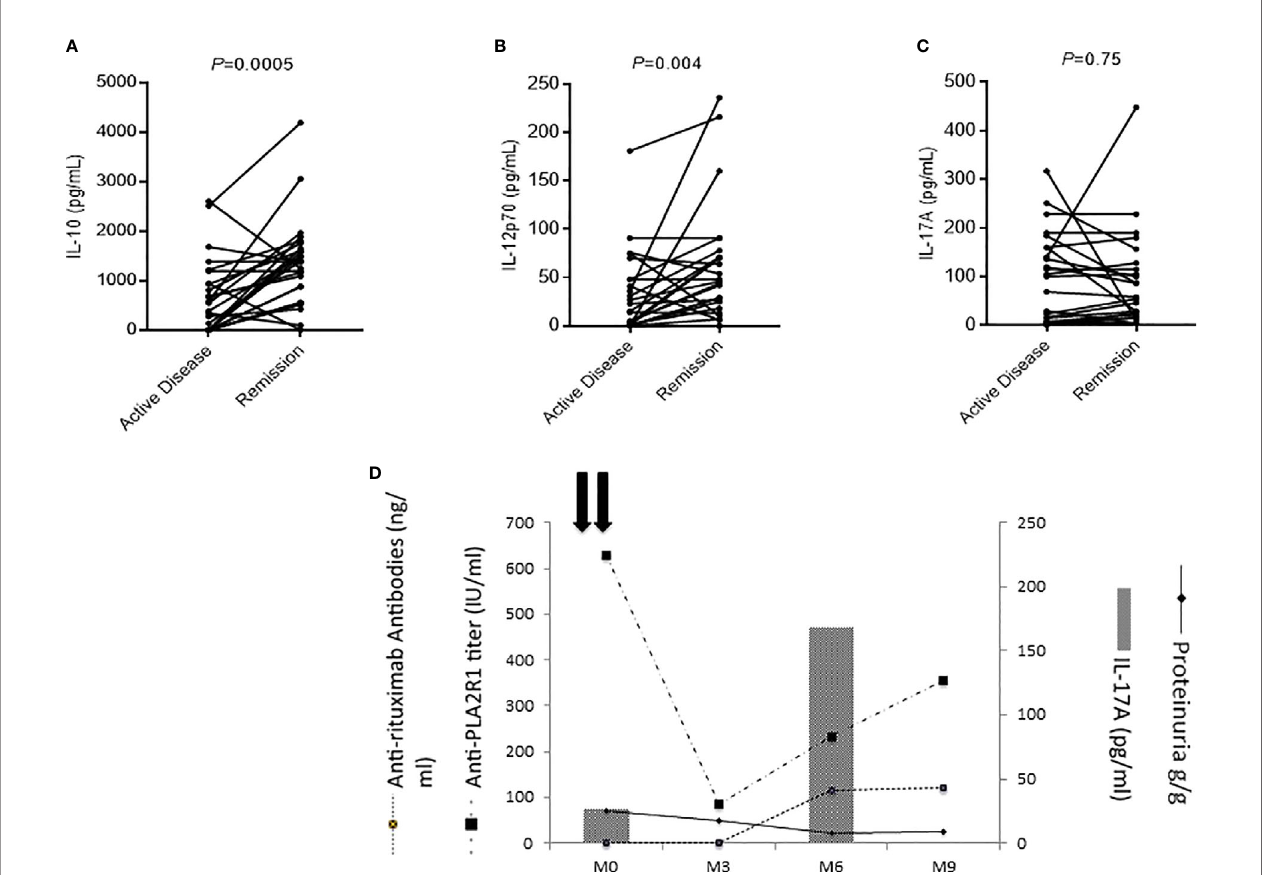
FIGURE 5 | Evolution of membranous nephropathy (MN) patients according to the level of cytokines. (A – C) Evolution of serum cytokine levels in MN patients who entered into remission ( n =26). Remission was associated with a signi fi cant increase of IL-10 (A) and IL-12p70 (B) levels, while the level of IL-17A remained unchanged (C) . A Wilcoxon matched pairs signed rank test was used to compare cytokine levels performed on the same MN patients during active disease and in remission. (D) Individual evolution of interleukin-17A levels of a MN patient according to his clinical evolution. This patient had low IL-17A levels before treatment with rituximab but developed antibodies against rituximab at month-6 associated with an increase of anti-PLA2R1 antibodies and an increase of IL-17A demonstrating a shift toward a Th17 pro fi